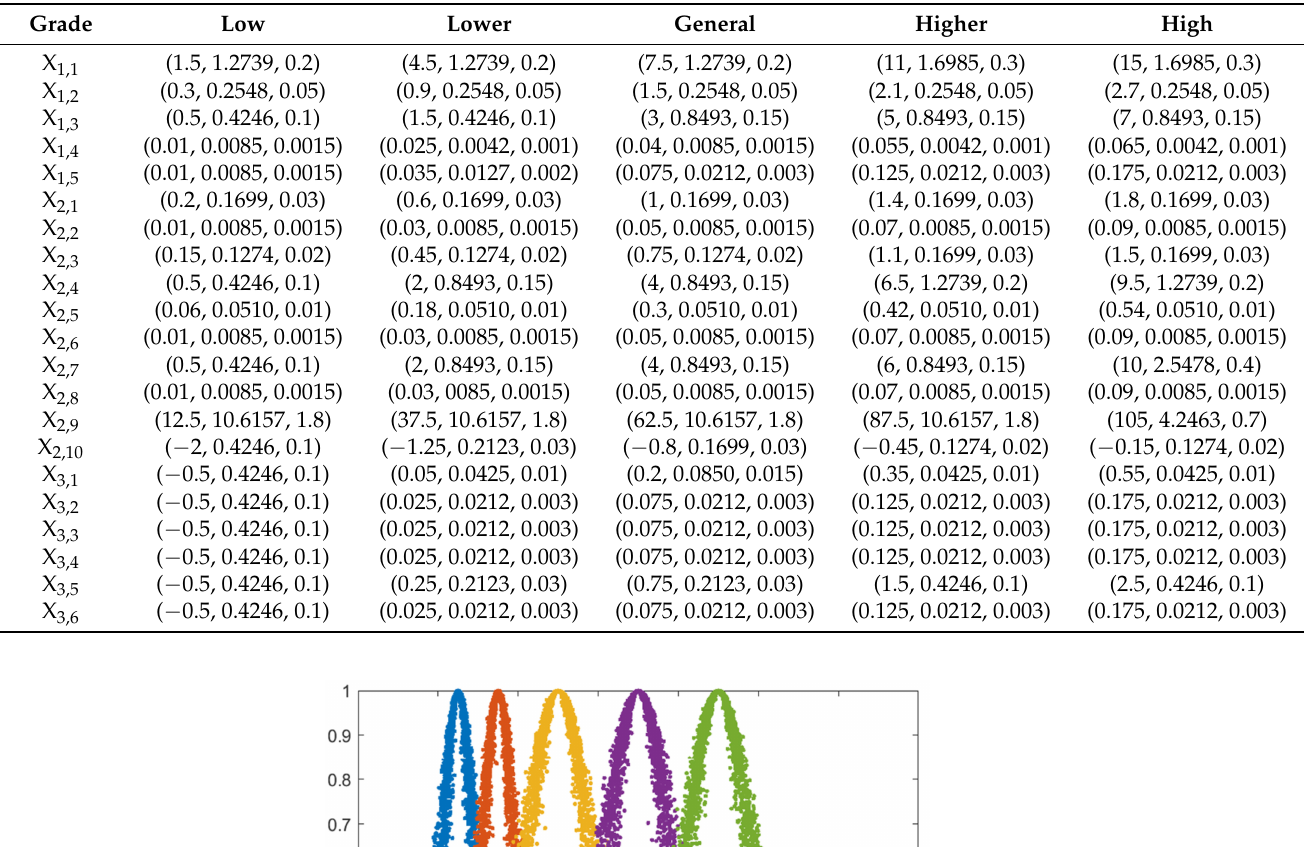
Table 7. Numerical feature values of each indicator cloud model.